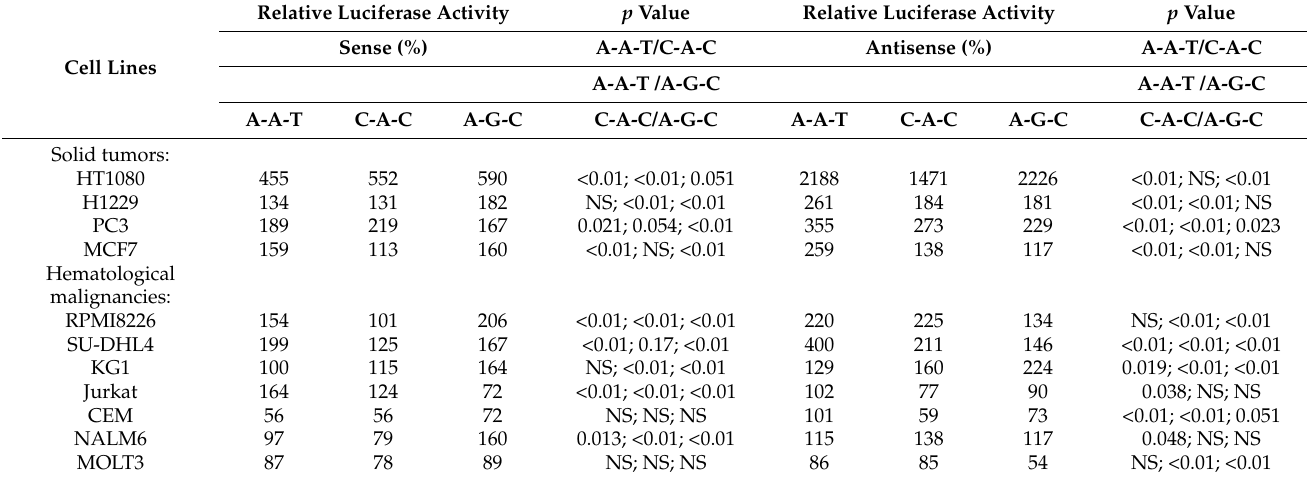
Table 1. Effect of SNPs on the reporter activity of the HPSE gene